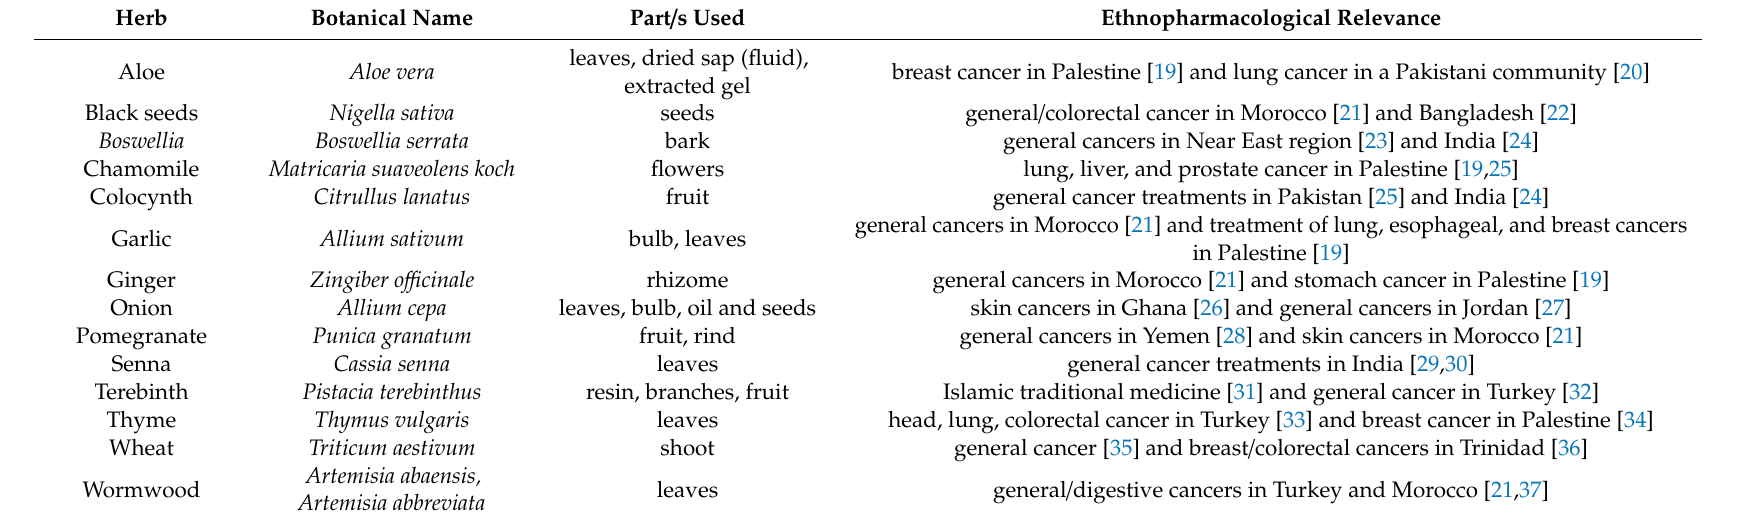
Table 1. Literature regarding ethnopharmacological relevance of the plants used in cancer.